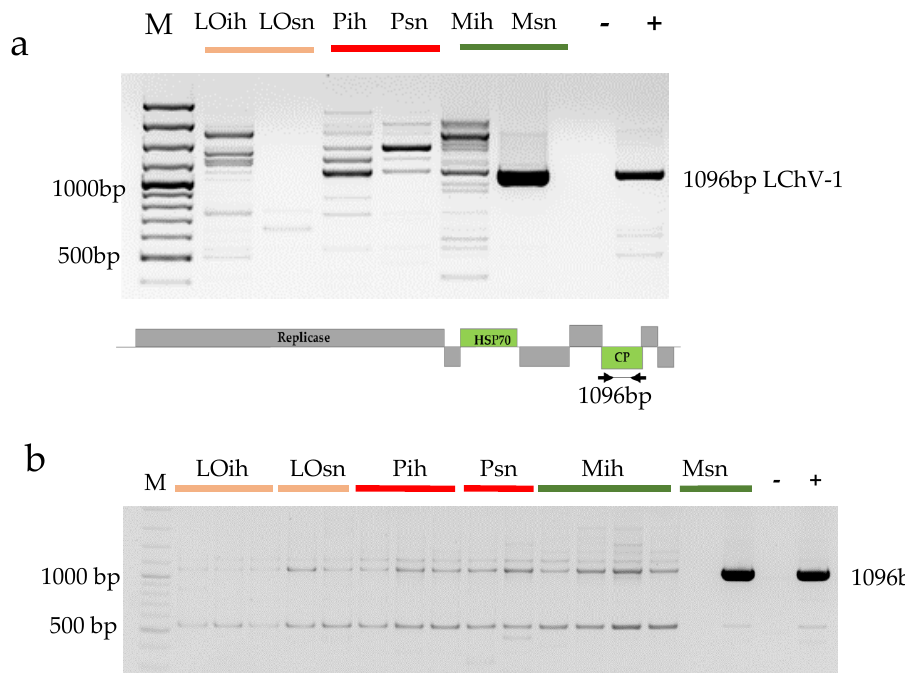
Figure 2. RT-PCR validation of the presence of LChV-1 in the ( a ) pooled individual RNAs representing the sequenced libraries and ( b ) RNAs from individual trees: LO-Ligeti ó ri á s, P-Pann ó nia kajszi, M-Magyar kajszi, ih-isolator house, sn-stock nursery. ( a ) The lower panel represents the genome of the virus indicating the PCR-amplified part, M- 100 bp Plus Gene Ruler, ( − ) negative, (+) positive